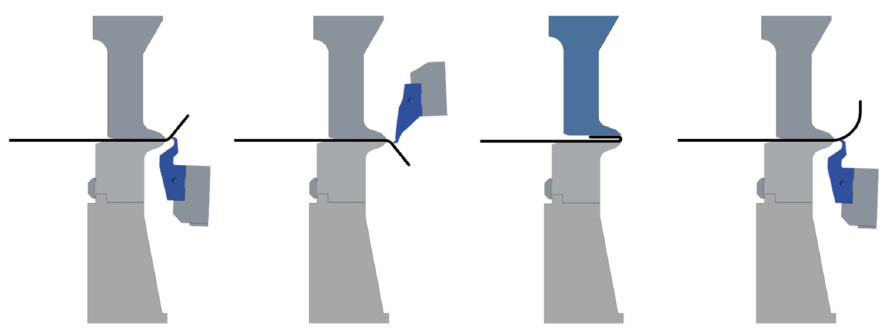
Figure 1. Schematic illustration of folding operation.